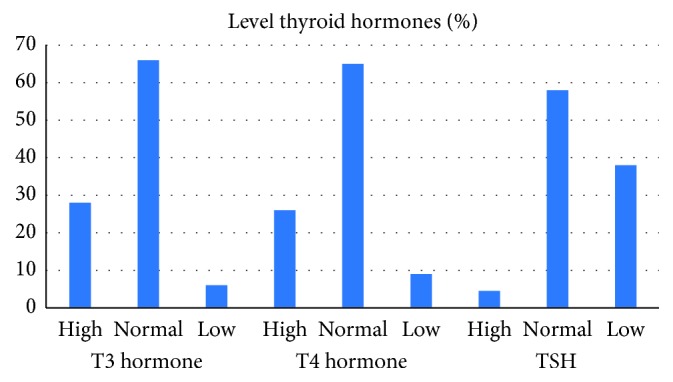
Levels of thyroid hormone among participants.